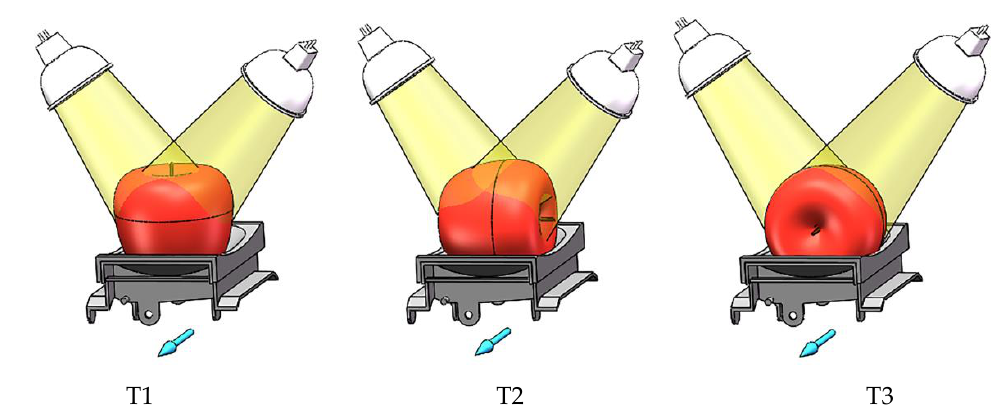
Figure 4. Schematic diagram of apple orientation (The arrow is the direction of movement and the black line is the equatorial plane of apples).